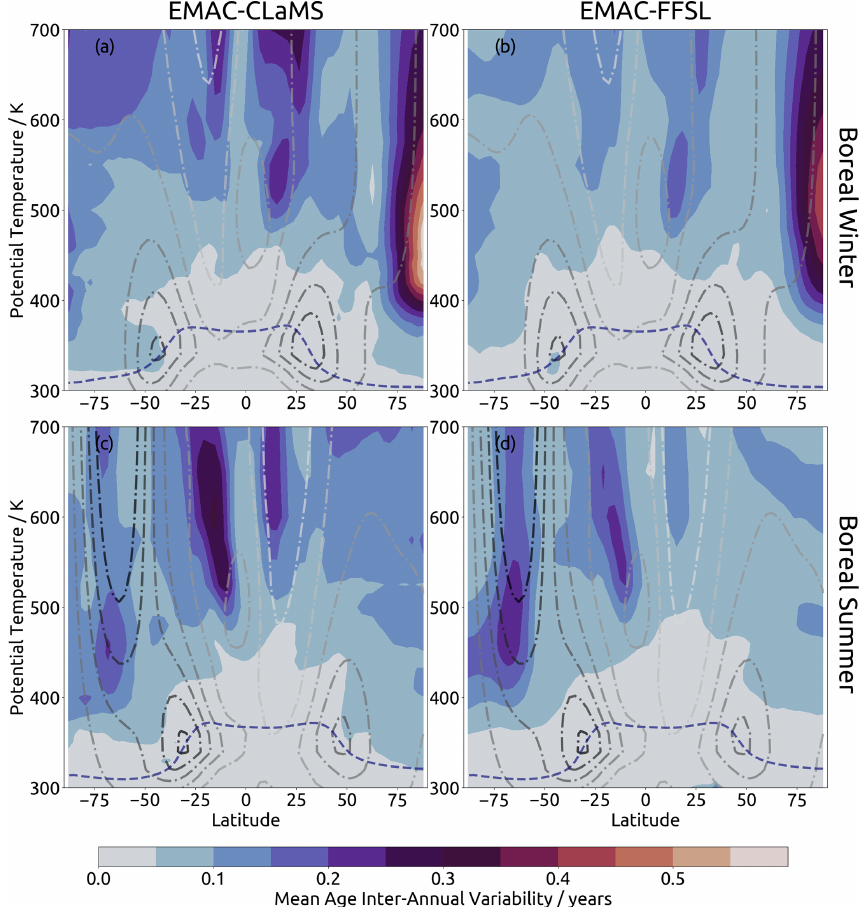
Figure 5. Standard deviation of spectra monthly-average mean age over the 10-year climatology from EMAC-CLaMS (a, c) and EMAC- FFSL (b, d) during boreal winter (a, b) and summer (c, d)